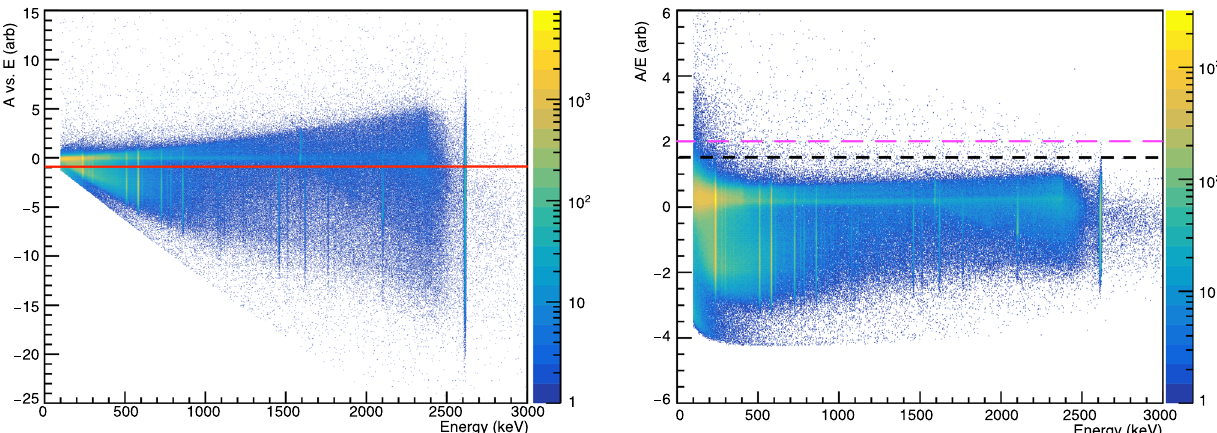
Fig. 4 The distribution of A vs. E (left) and A/E (right) values with respect to energy is shown for calibration events after the muon veto is applied. The color scale indicates the number of events. A vs. E is used to identify multi-site γ background events; all events with A vs. E less than -1 (indicated by the red line) are rejected. A/E is used to identify